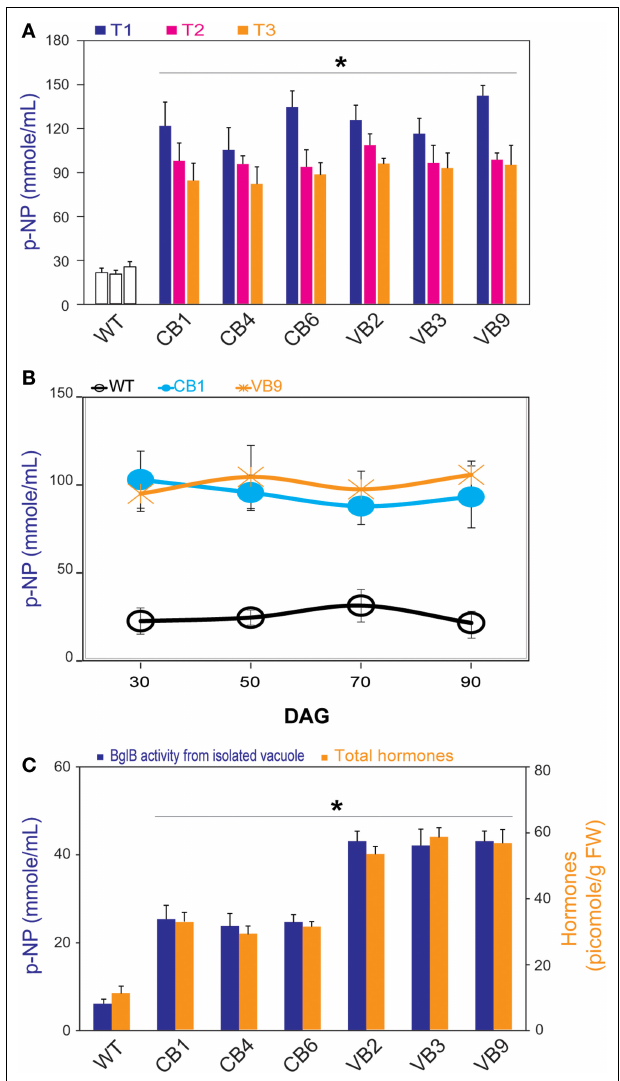
FIGURE 2 | β -glucosidase enzymatic activity and total hormones levels . (A) Significant higher β -glucosidase enzymatic activity of heterologously expressed BglB during three generations of CB and VB transgenic plants compared to WT plant. (B) Profile pattern of β -glucosidase enzymatic activity of heterologously expressed BglB in CB and VB transgenic plants in T 1 generations, from 30 to 90 DAG revealed the significant higher β -glucosidase enzymatic activity of CB and VB transgenic plants compared to WT plants. (C) Significant higher β -glucosidase enzymatic activity of heterologously expressed BglB from isolated vacuole and the total hormones levels of CB and VB transgenic plants compared to WT plant at 14 DAG. Vacuole was isolated after protoplasts preparation from 14 DAG tobacco seedlings (WT and transgenic), broken by sonication within 5min in 0.5 cycle/60% amplitude in protein extraction buffer at pH 8.0 (50mM Tris–HCl, 5mM Na 2 -EDTA, 20mM Na 2 S 2 O 5 × 5H 2 O, 100mM KCl, 5% glycerol, 1% β -mercaptoethanol), and concentrated by UFC 710008/Centricon Plus-70 Centrifugal filter (EM Millipore, USA). Average values were calculated from triplicate ( n = 3) of each transgenic lines and WT plants. *indicates significant differences from the control (WT) ( P < 0.05).